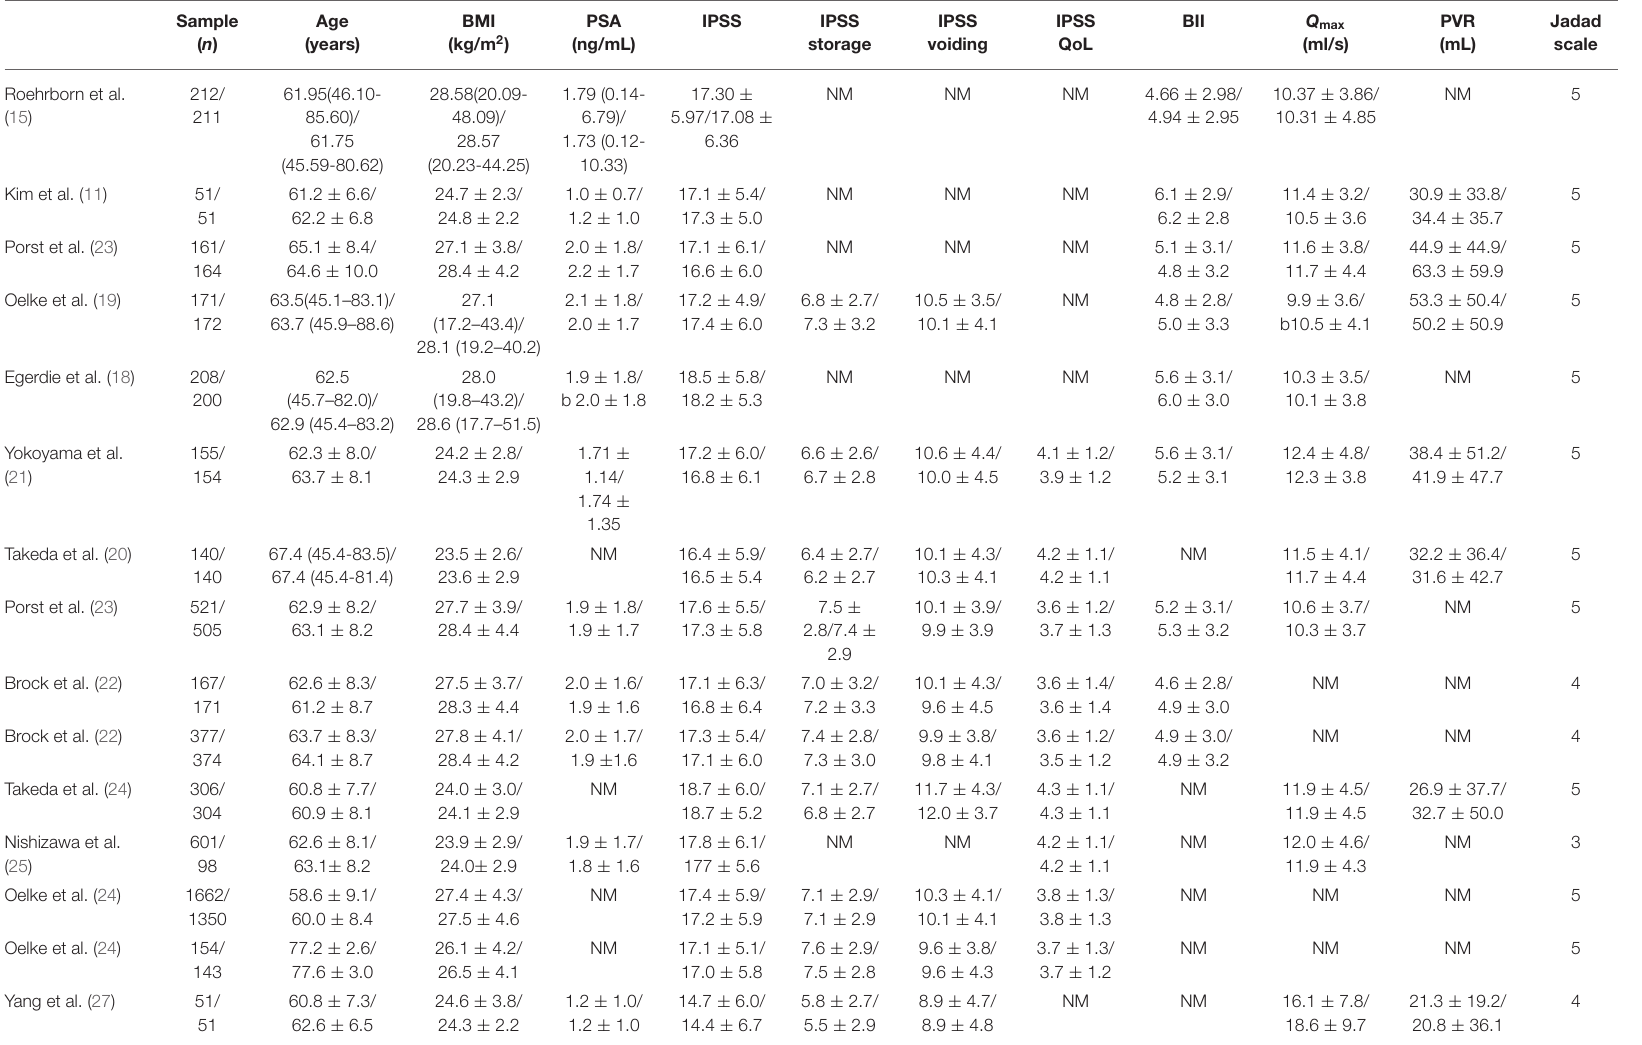
TABLE 1 | Participant demographic and baseline characteristics of the included studies.